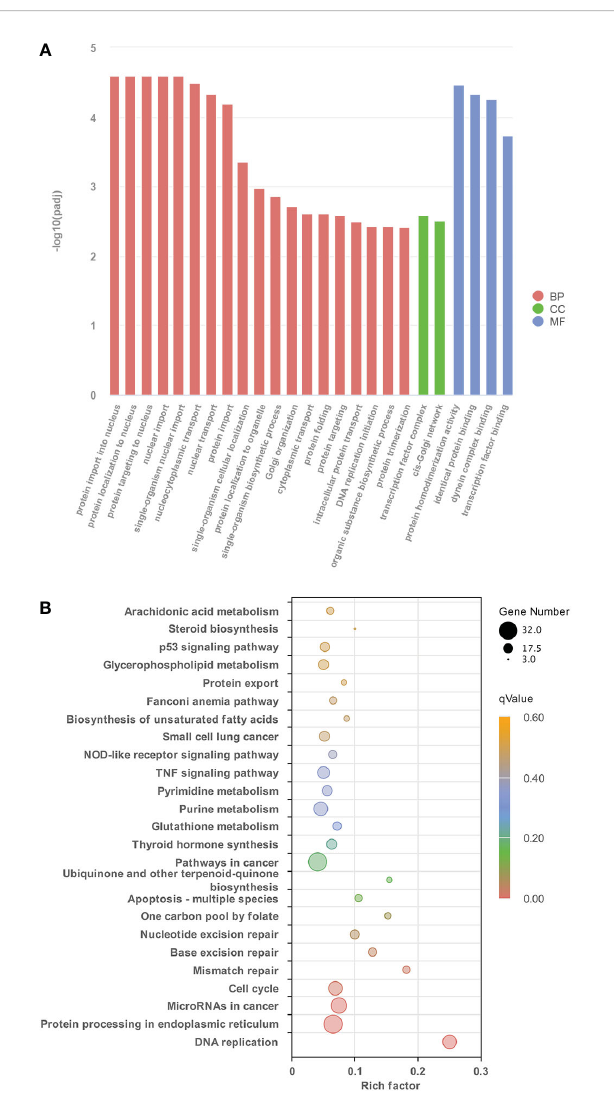
FIGURE 2 The characteristics of GO terms and KEGG pathways signi fi cantly enriched between control group and TH treatment group. (A) The top 25 GO terms enriched in DETs identi fi ed from control group and TH treatment group ( p < 0.05) (B) Signi fi cantly enriched KEGG pathways of DETs between control group and TH treatment group ( p < 0.05). GO, Gene Ontology; KEGG, Kyoto Encyclopedia of Genes and Genomes; TH, thyroid hormone; DETs, differentially expressed